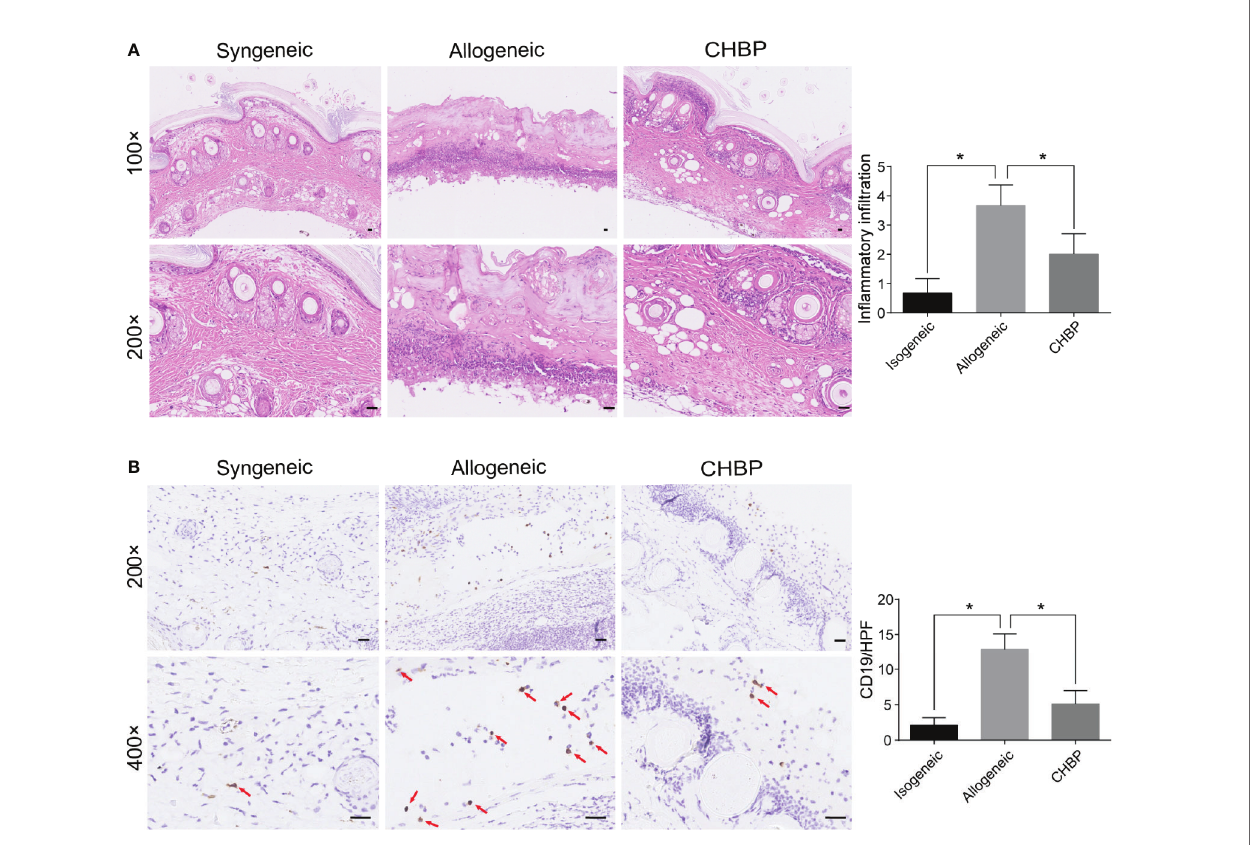
FIGURE 2 | CHBP decreased the in fl ammatory cell in fi ltration and CD19+ B cell in fi ltration in skin allografts. (A) Representative images of H&E staining in the syngeneic, allogeneic, and CHBP groups and semi-quanti fi cation of in fl ammatory cell in fi ltration in the three groups. (B) Representative images of immunohistochemical staining (IHC) for CD19 in the syngeneic, allogeneic, and CHBP groups and semi-quanti fi cation of IHC staining in the three groups. *P <